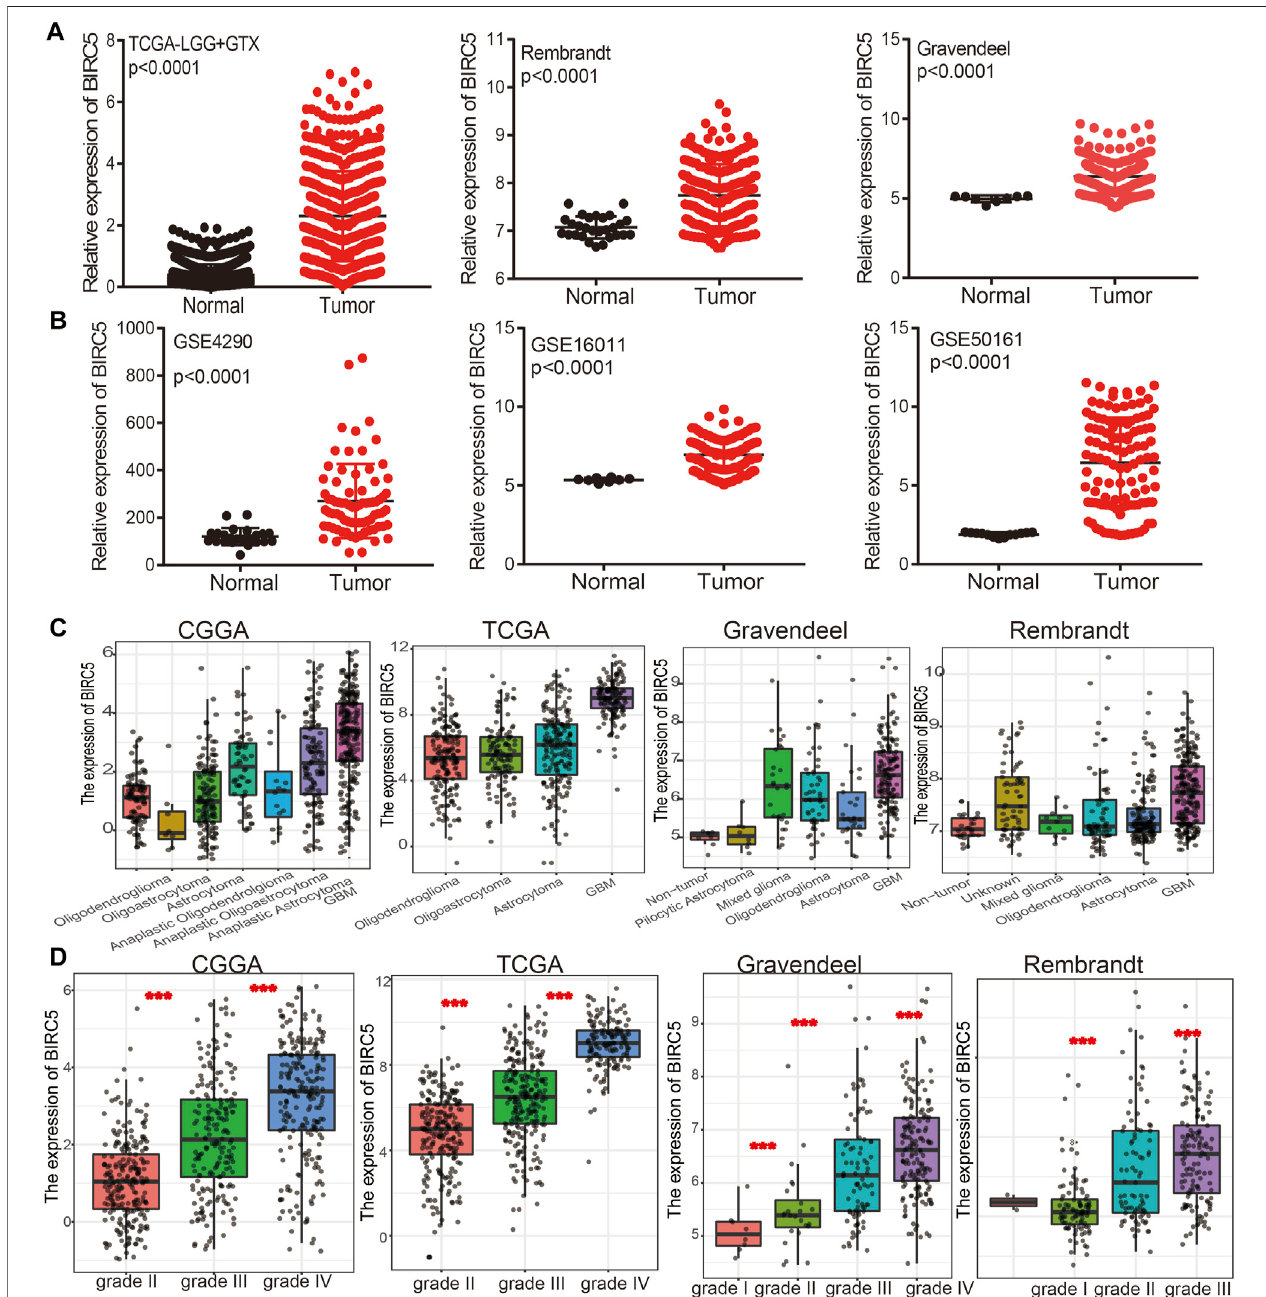
FIGURE 2 | BIRC5 was highly expressed in low grade glioma. (A,B) BIRC5 was upregulated in glioma examined by the TCGA, Rembrandt, Gravendeel, and GEO datasets. (C,D) BIRC5 expression levels among glioma patients with different histological subtype (C) and tumor grade (D) in TCGA-LGG.